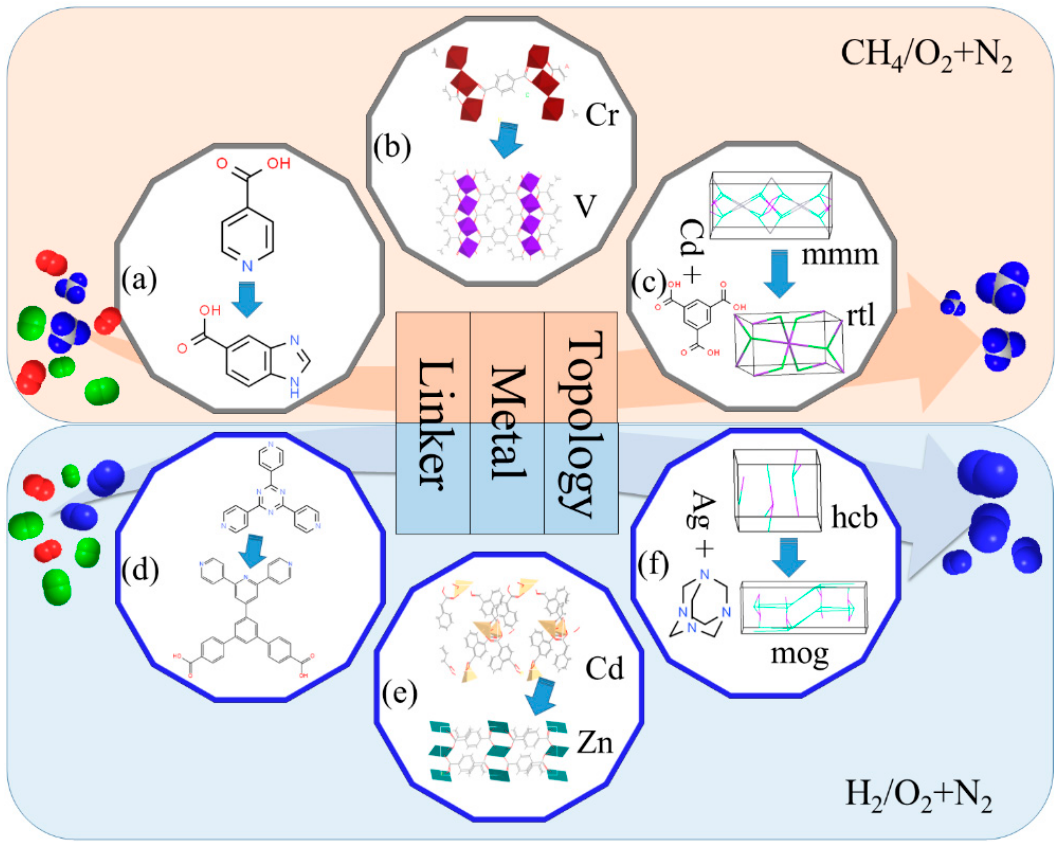
Figure 6. Three design strategies for boosting the separation of ( a – c ) CH 4 /O 2 + N 2 ; and ( d – f ) H 2 /O 2 + Figure N 2 .